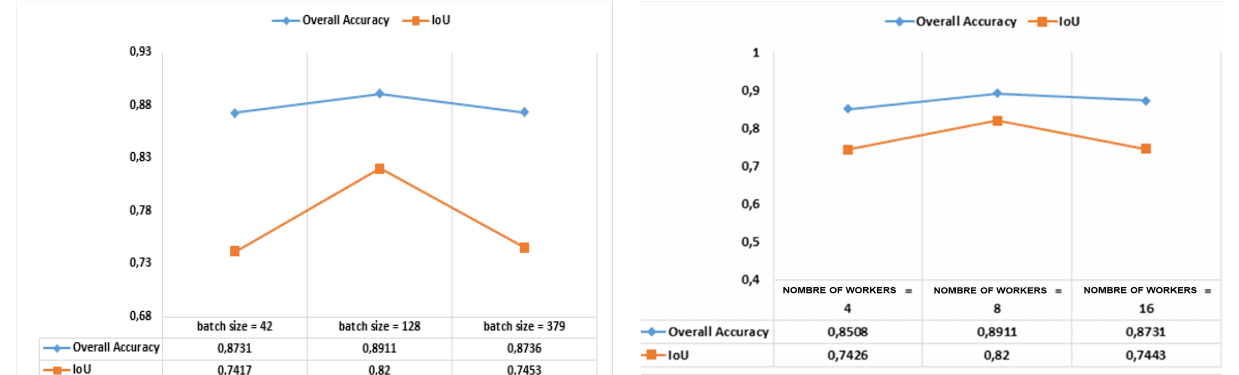
Figure 22. Sensitivity of the number of workers on the model performance